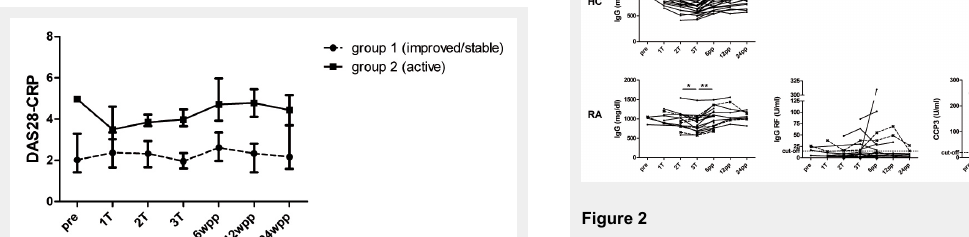
Immunoglobulin levels, IgG-RF and ACPA during and after pregnancy in healthy and rheumatoid arthritis patients. Levels of the immunoglobulin IgG, IgG-RF and IgG-ACPA (anti-CCP3 ELISA) in healthy women (HC, n = 29) as well as in patients with rheumatoid arthritis (RA, n = 22) analysed before conception (pre), at the 1 st (1T), 2 nd (2T) and 3 rd (3T) trimester as well as 6, 12 and 24 weeks postpartum (wpp). RF and ACPA levels are shown in RA patients with persistent active disease (dashed lines) and in those with low disease activity during pregnancy (black lines). * P <0.05, ** P